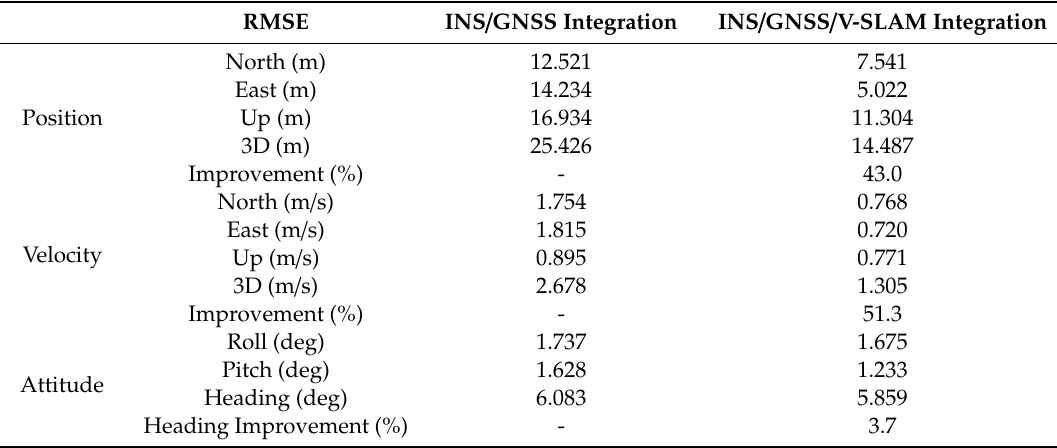
Figure 16. Graphical comparison of the navigation errors associated with the various solutions in the second test. Table 5. Statistical summary of navigation errors in the second test.